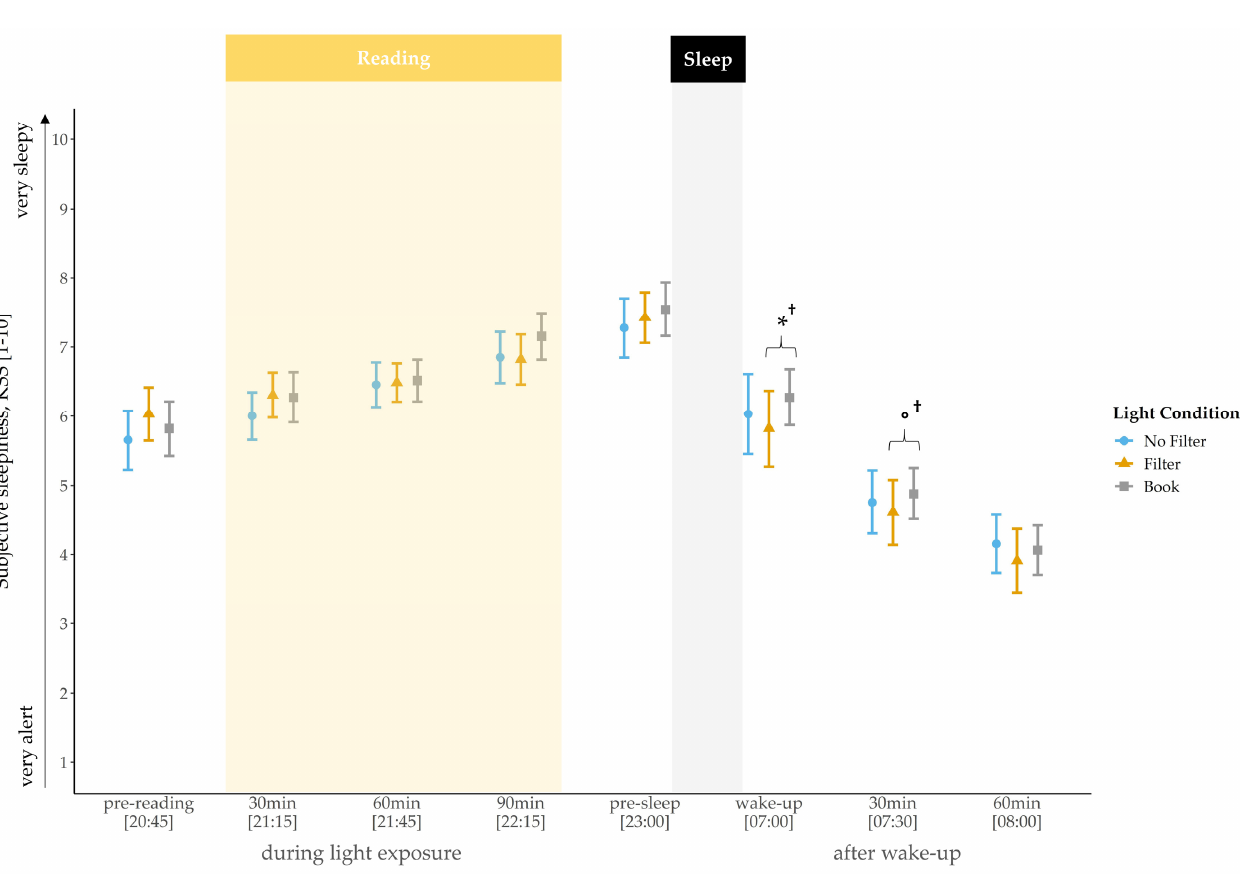
Figure 1. Trajectory of subjective sleepiness (mean and 95% confidence intervals). Subjects were significantly more tired at awakening and by trend more tired 30 min post-awakening after reading a book compared to reading on a smartphone with a filter. Yellow background = light exposure (reading session); gray background = lights turned off (sleep). *: p ≤ 0.05; ◦ : p < 0.10; †: p adj . >